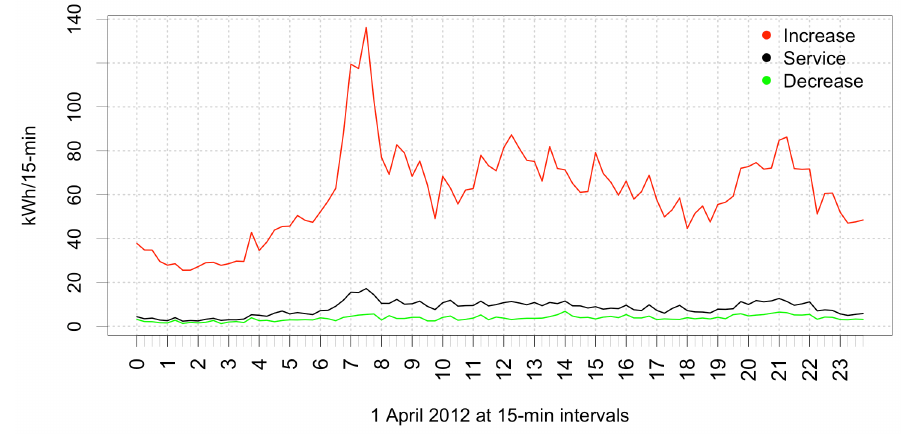
Figure 9. Aggregate load profile of 14 homes at 15-min intervals. The vertical distance from the black line down to the green line is the instantaneous load that could be shed. The vertical distance from the black line up to the red line is the instantaneous load that could be added. The large red spikes indicate significant load adding opportunities, e.g., after completion of morning DHW heating. Greater mid-day and evening load shaping opportunities were also